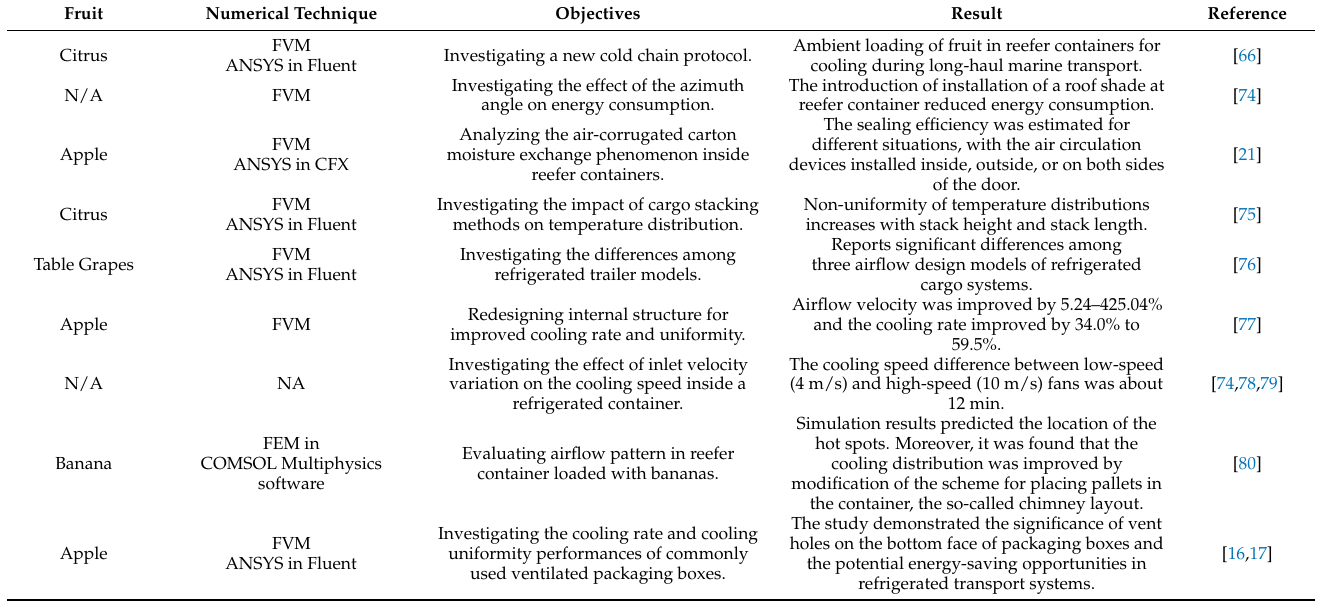
Table 4. Objectives, numerical techniques, and results of computational-fluid-dynamics-based analysis in reefer container